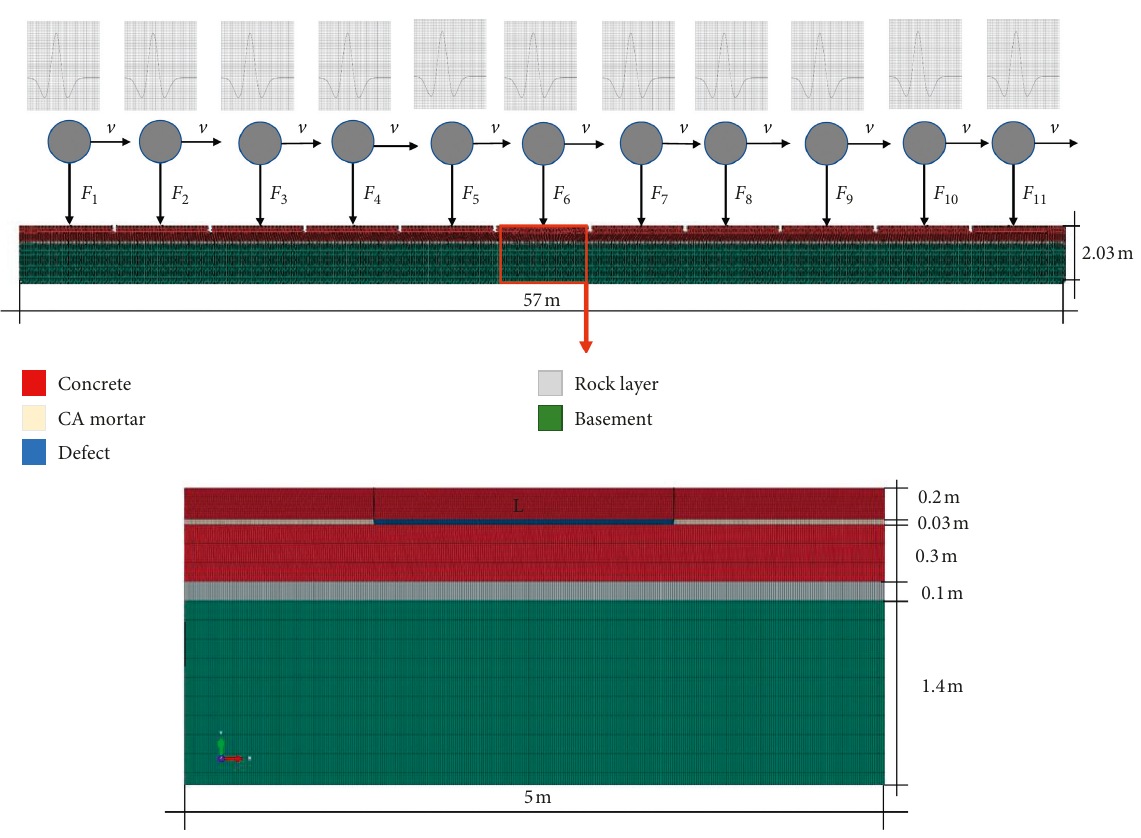
Figure 4: Finite element model of the underline structure. Table 1: Model material